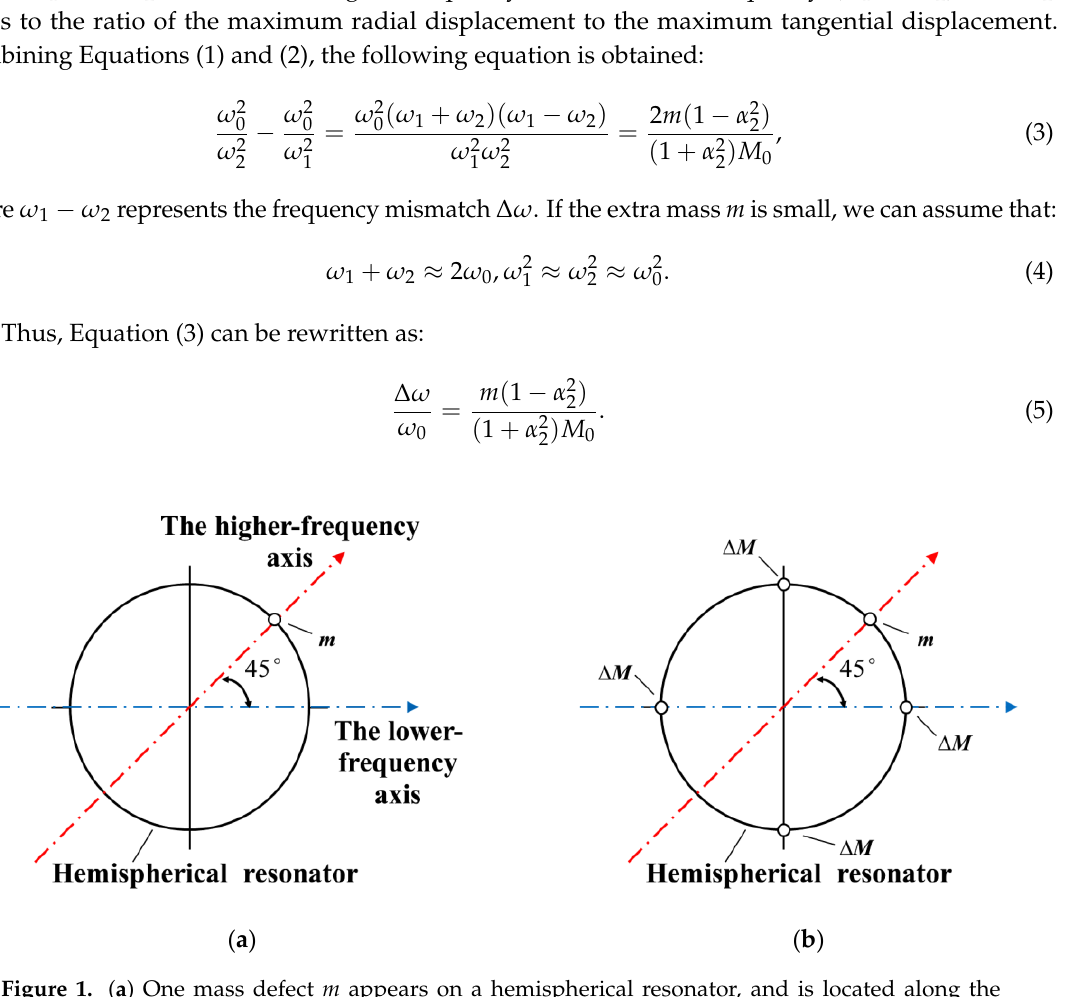
Figure 1. ( a ) One mass defect m appears on a hemispherical resonator, and is located along the higher-frequency axis. ( b ) Four mass points ∆ M are removed symmetrically from the edge of a hemispherical resonator.